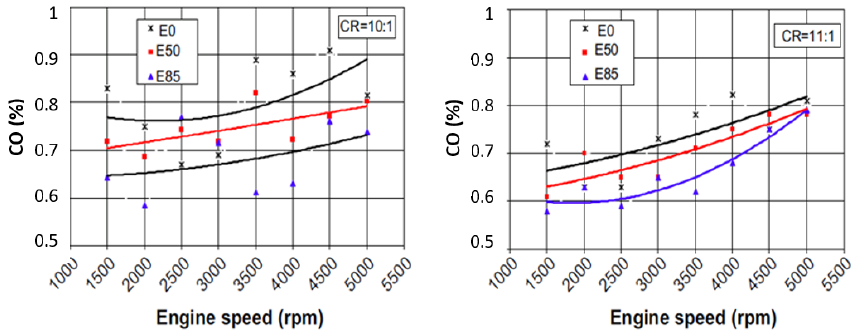
Figure 5. Variation in CO emissions with engine speed and ethanol content in the blends at different compression ratios (CR=10:1 on the left and CR=11:1 on the right): comparison between gasoline (E0), 50% ethanol v/v (E50) and 85% ethanol v/v (E85) [94]. Reproduced with permission from Renewable Energy; published by Elsevier, 2009. License Number: 5094080704915.